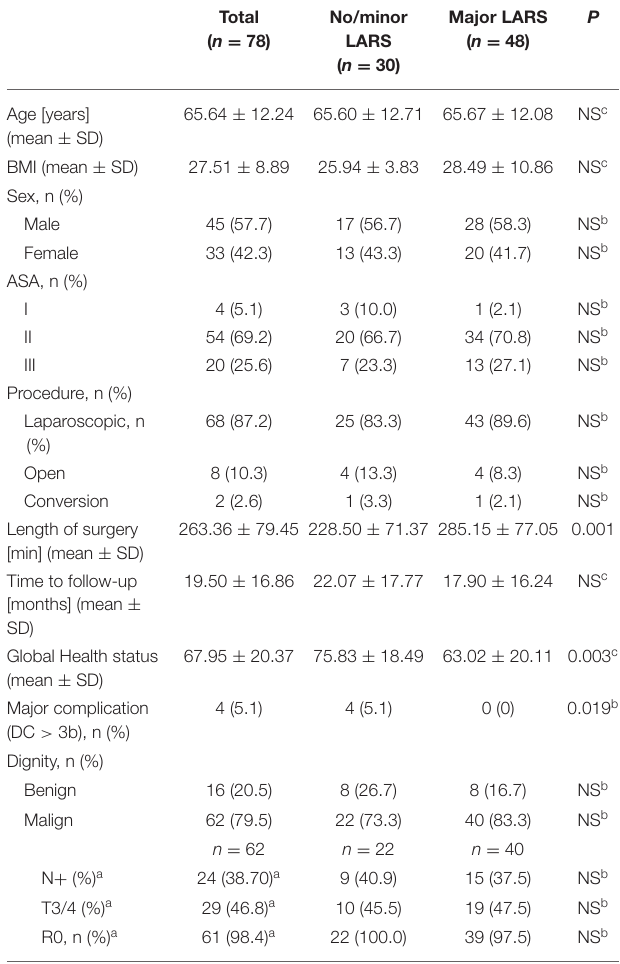
TABLE 1 | Patient characteristics according to LARS/Major